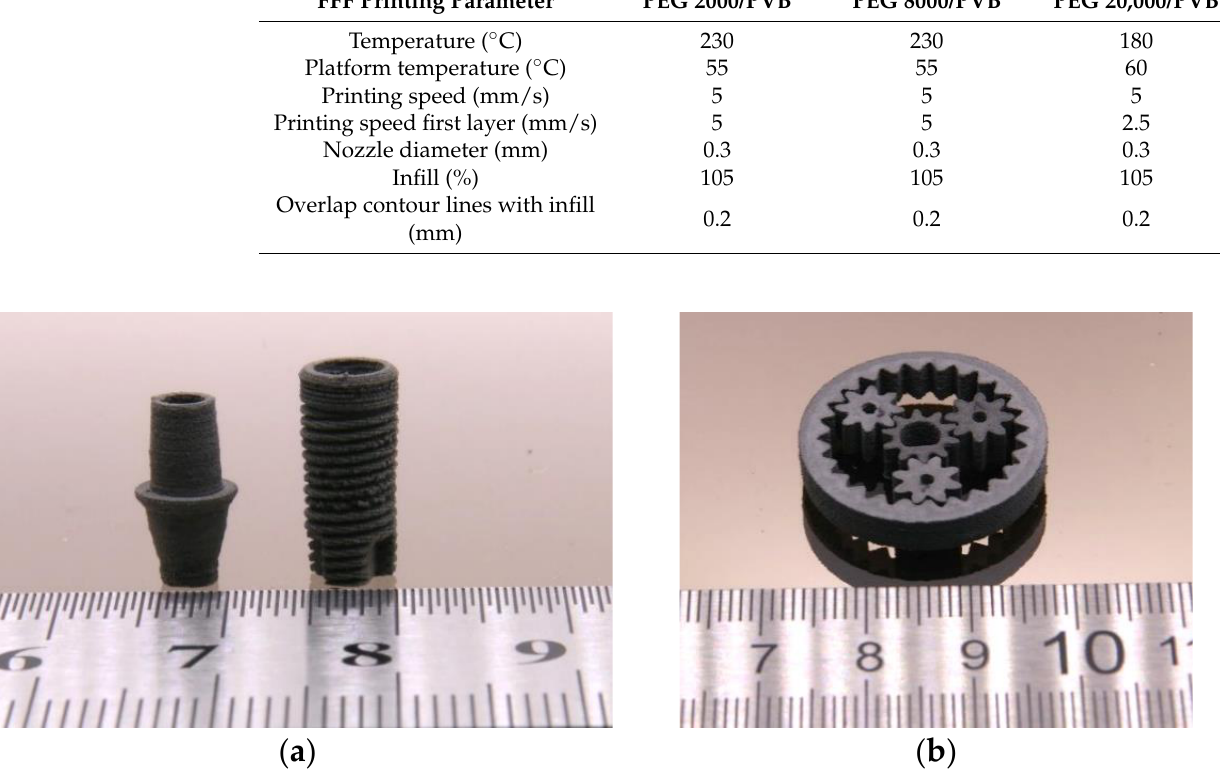
Figure 14. FFF-printed PEG 20,000/PVB parts. ( a ) Dental implant; ( b ) planetary gear train.